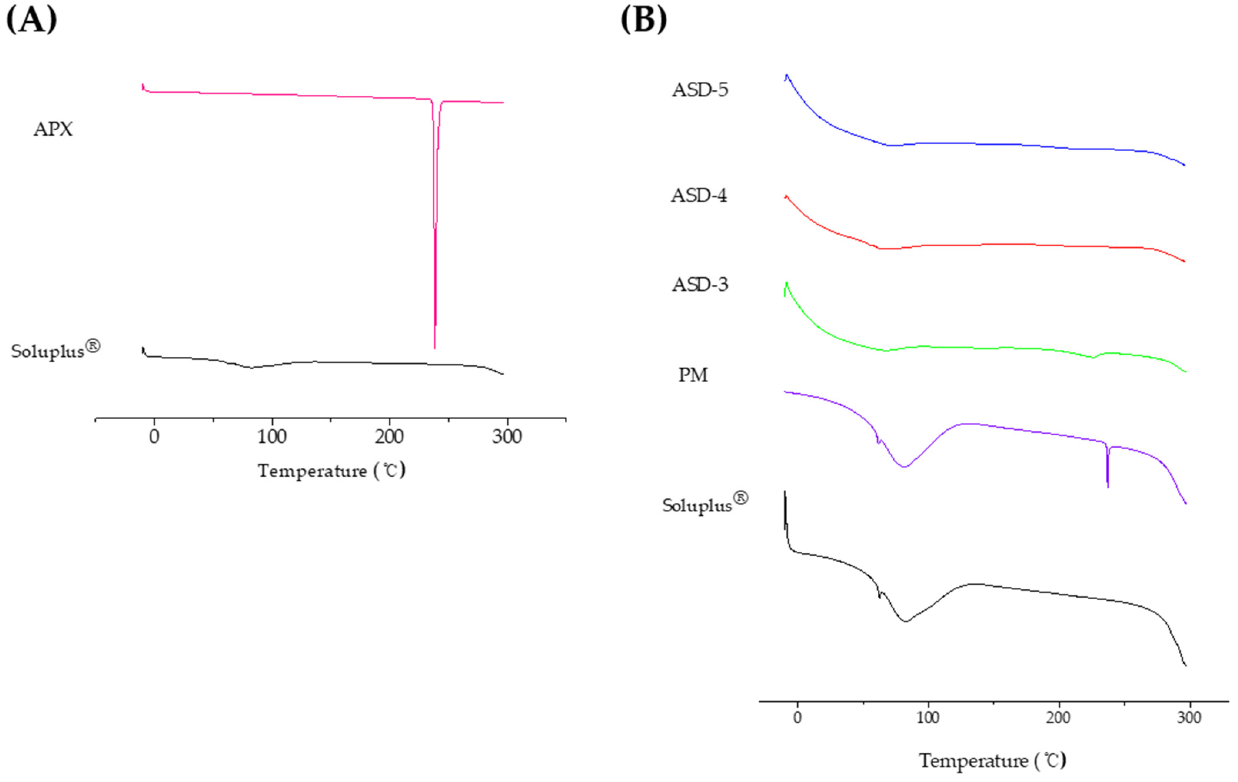
Figure 2. DSC thermograms of ( A ) pure APX and Soluplus ® ( B ) APX-Soluplus ® PM and Formulations ASD 3, ASD 4 and ASD 5.